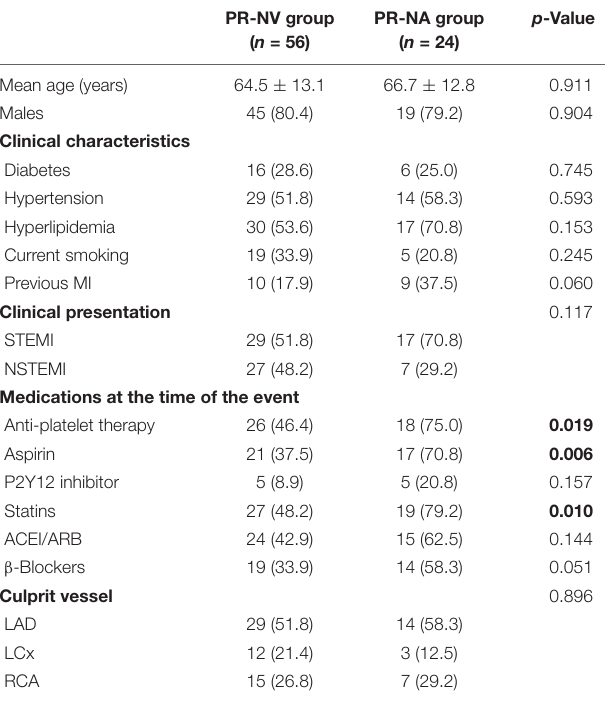
TABLE 1 | Baseline demographics of the studied population.